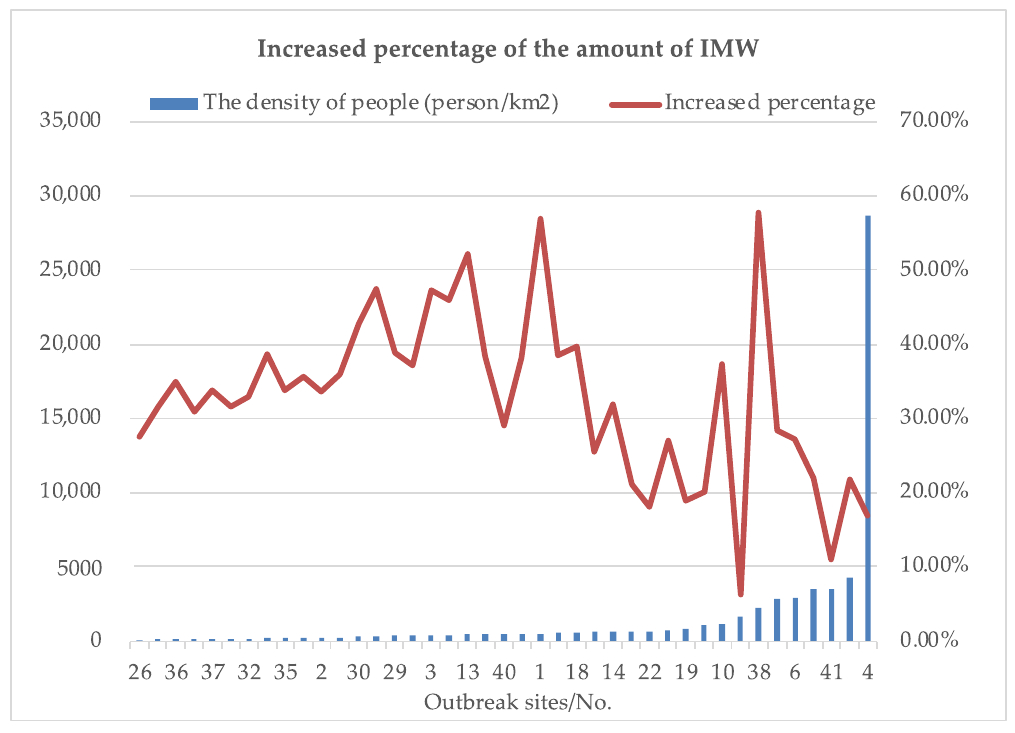
Figure 9. Effects of different outbreak sites (sorted according to population density) on the amount of IMW.